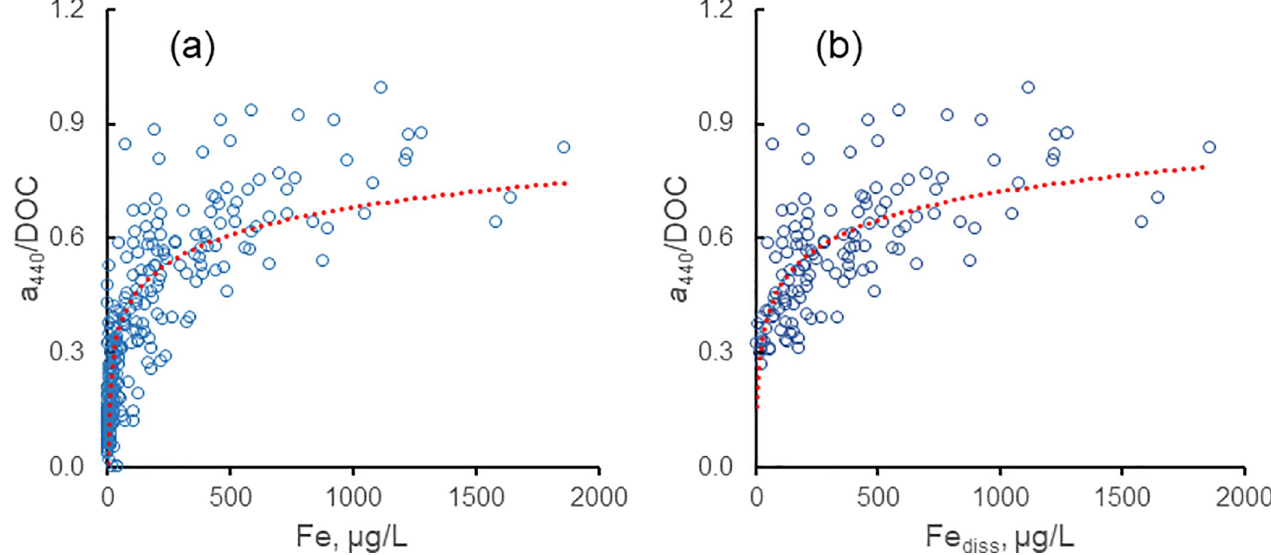
Fig 4. (a) a 440 /DOC vs. Fe diss for all data, R 2 = 0.64; (b) a 440 /DOC vs. Fe diss for sites with a 440 > 3.0 m -1 , R 2 = 0.46. (R 2 are for fit of a 440 /DOC to ln(Fe diss )).